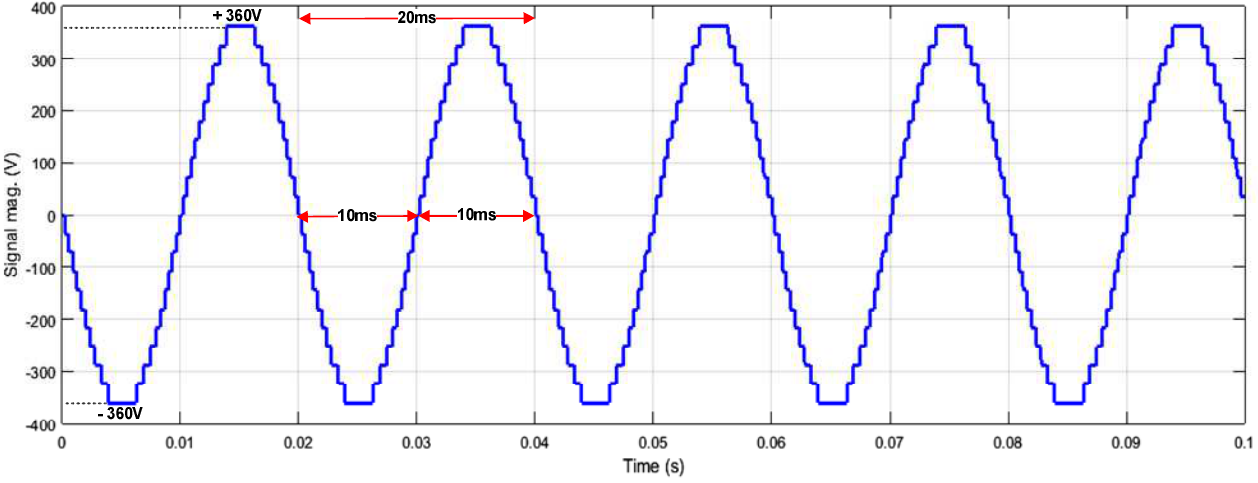
Figure 23. Continuous stepped sine-wave output voltage of the 21-level multilevel inverter using the SHE digital switching controller.